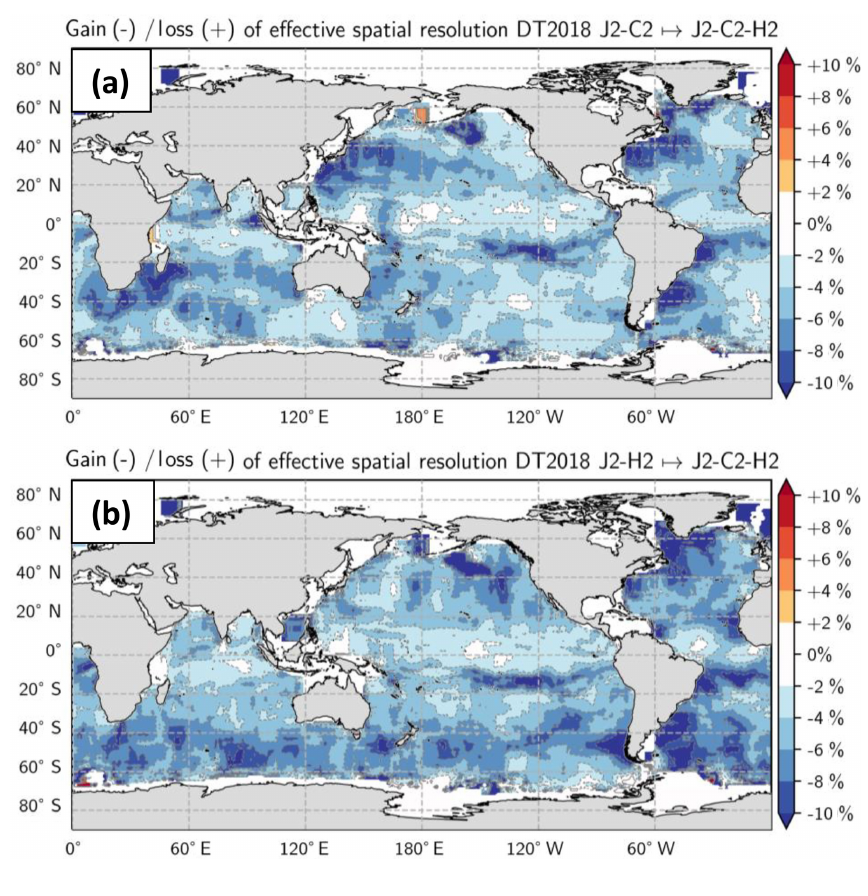
Figure 6. Impact of the satellite constellation on the effective resolution – ratio of effective resolution of (a) maps constructed with C2-H2-J2 vs. C2-J2 and (b) maps constructed with C2-H2-J2 vs.